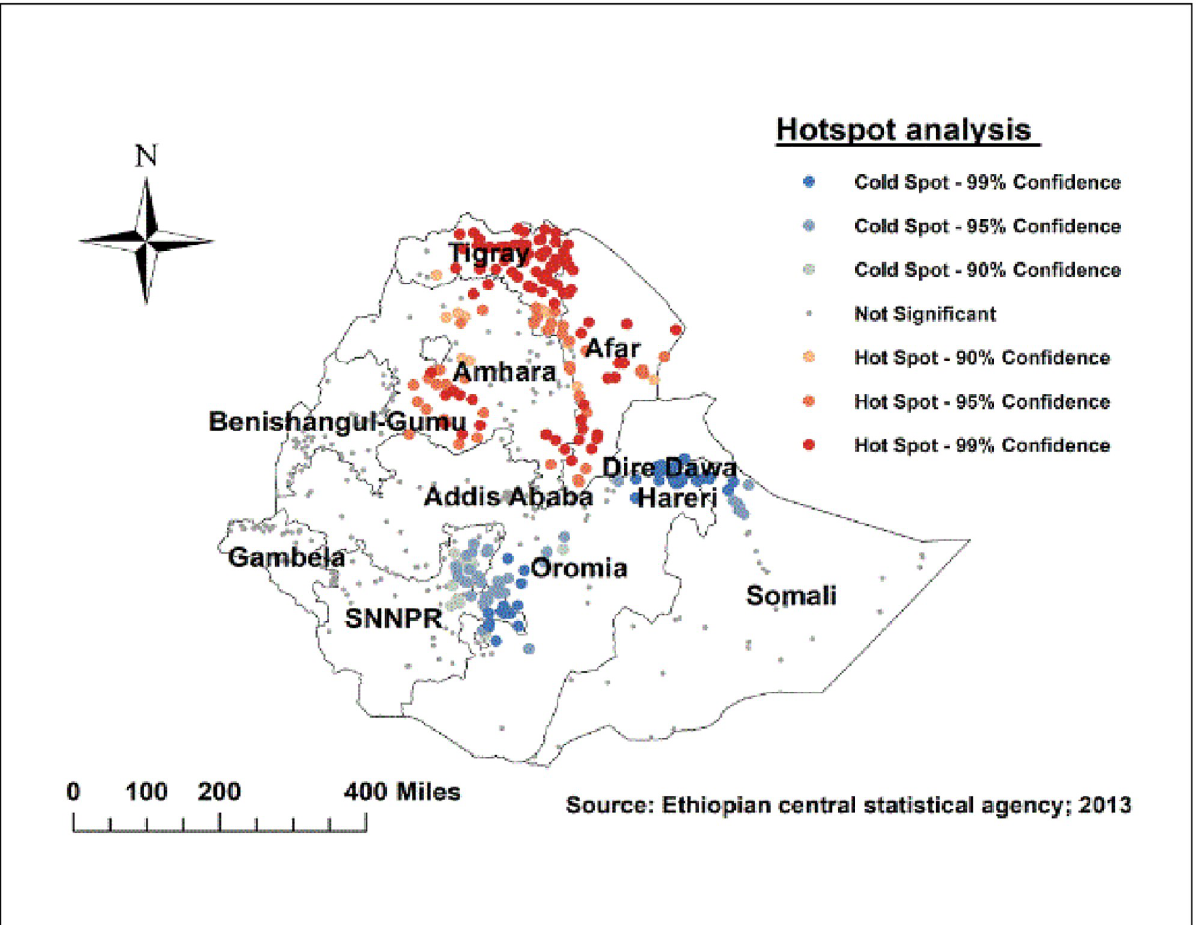
Fig 4. Hotspot analysis of delayed initiation of breastfeeding in Ethiopia,